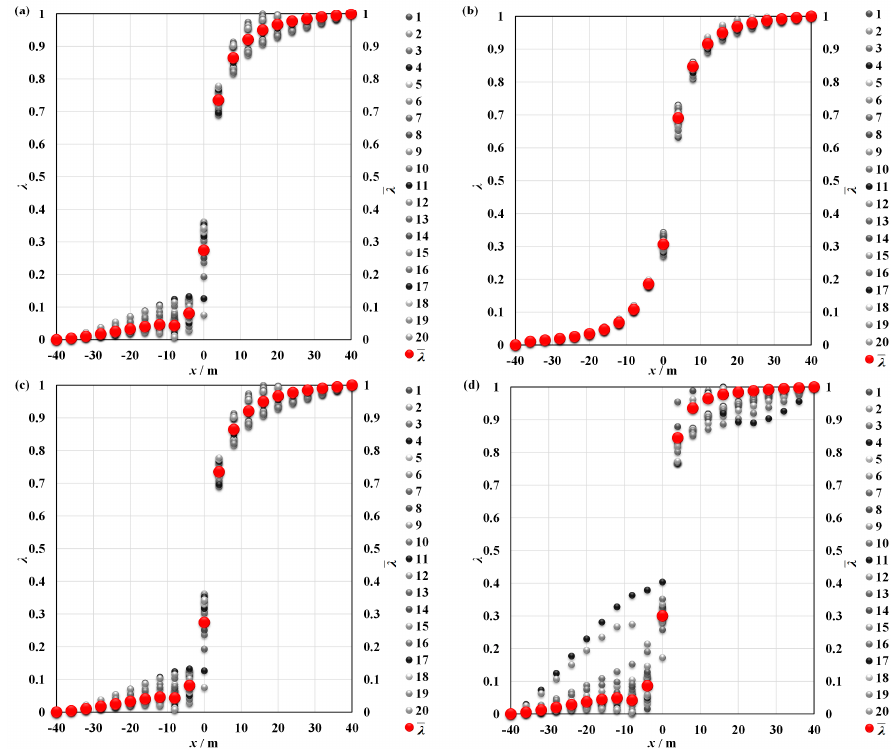
Figure 14. Longitudinal displacement profile: ( a ) case 1, ( b ) case 2, ( c ) case 3, ( d ) case 4. Appl. Sci. 2020 , 10 , x FOR PEER REVIEW 16 of 19